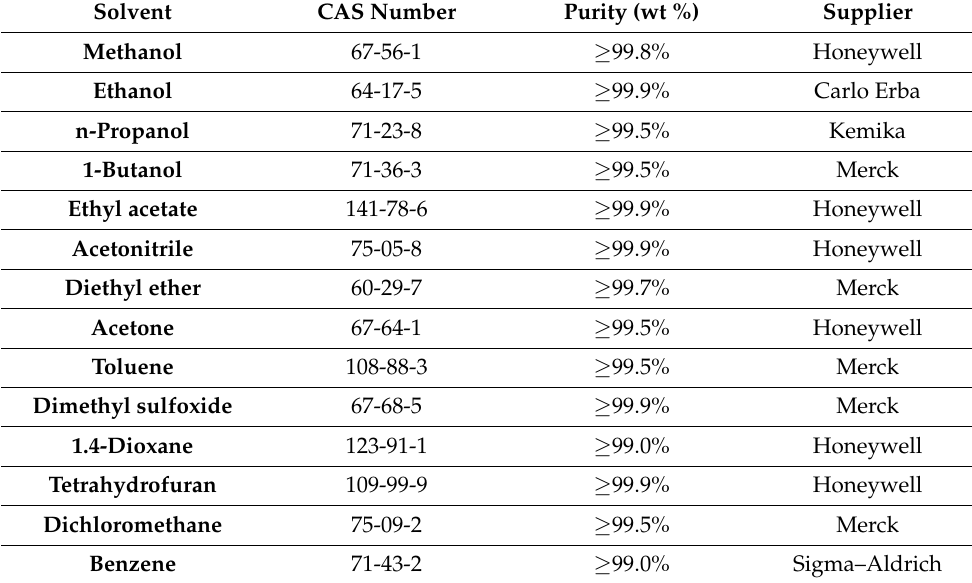
Table 2. Solvents and their CAS number, purity and